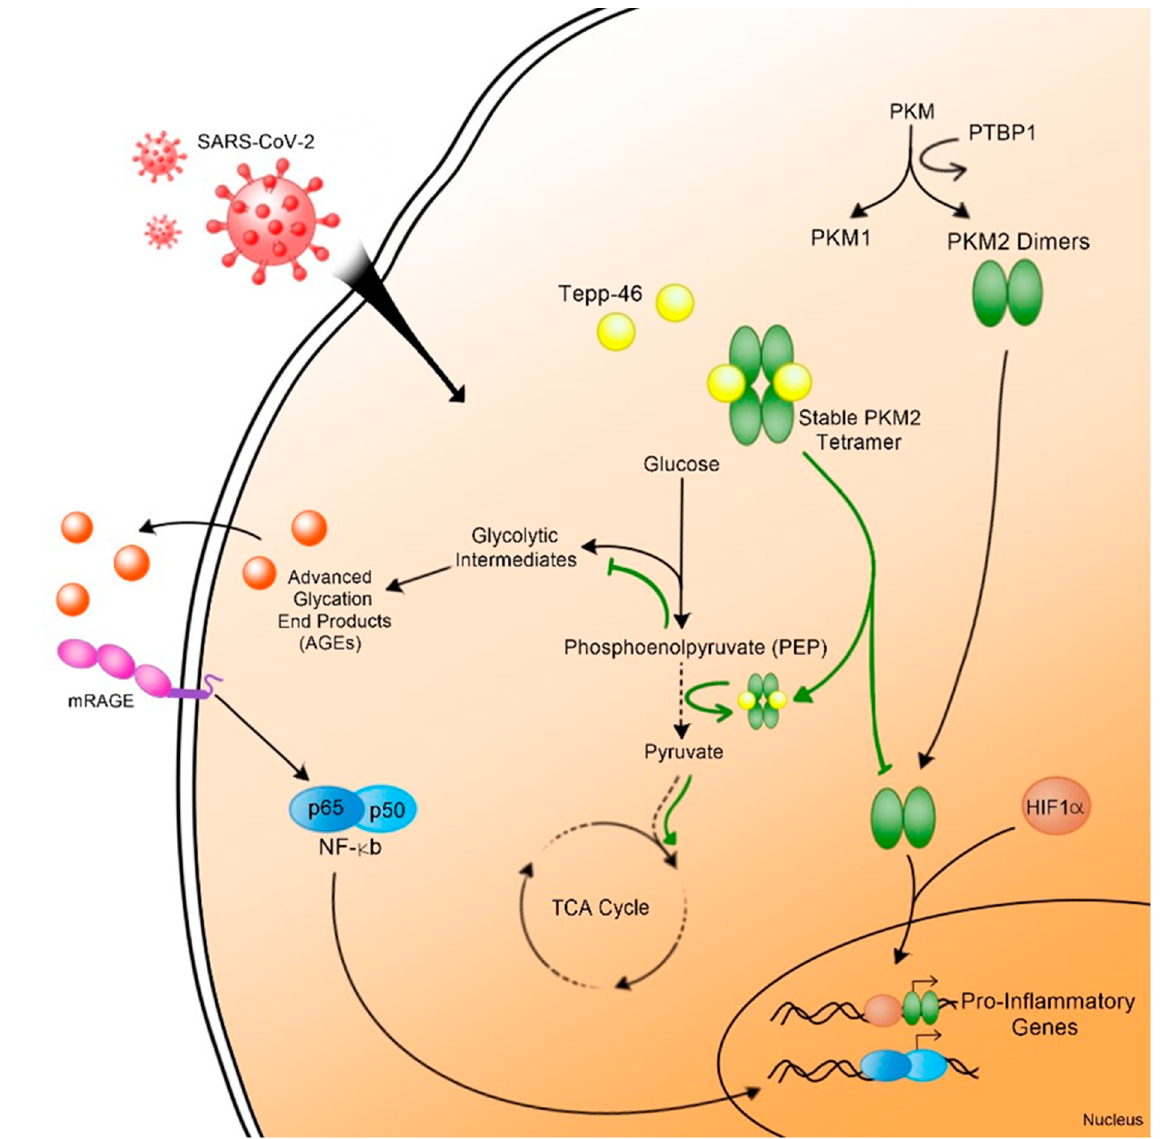
Figure 6. Schematic representation of metabolic reprograming leading to RAGE signaling and inflammation pathways in post-acute COVID-19 (black arrows). PKM2 stabilizer, Tepp-46, reverses this metabolic reprogramming and inhibits RAGE signaling (green arrows).